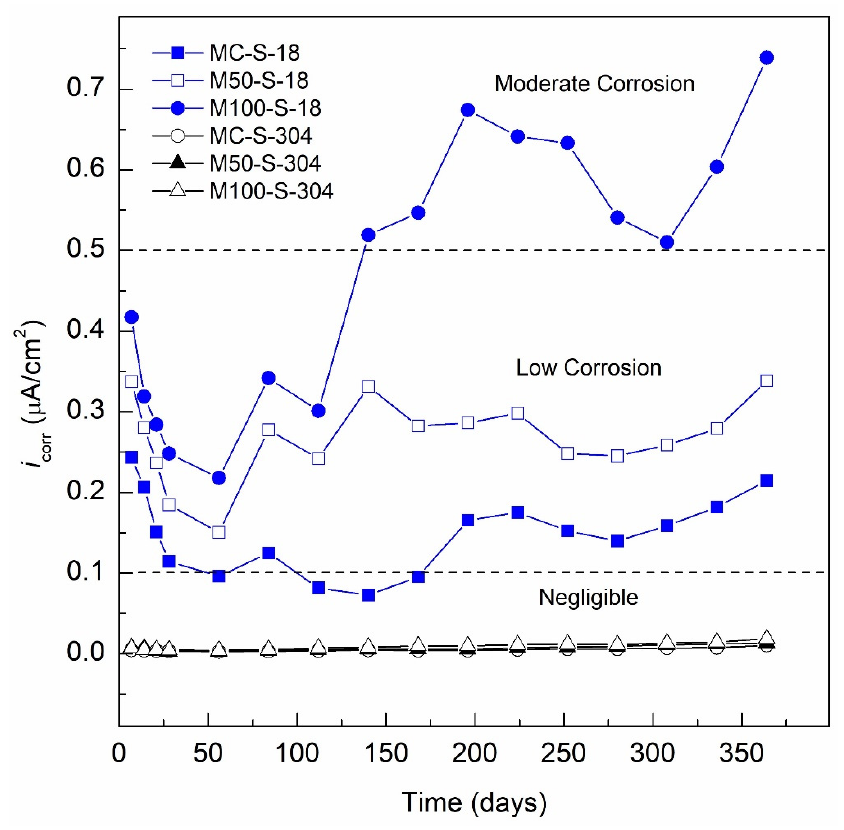
Figure 7. i corr specimens exposed 3.5 wt.% Na 2 SO 4 solution (aggressive medium).